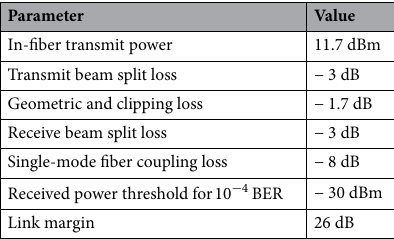
Table 2. Demonstration link budget.